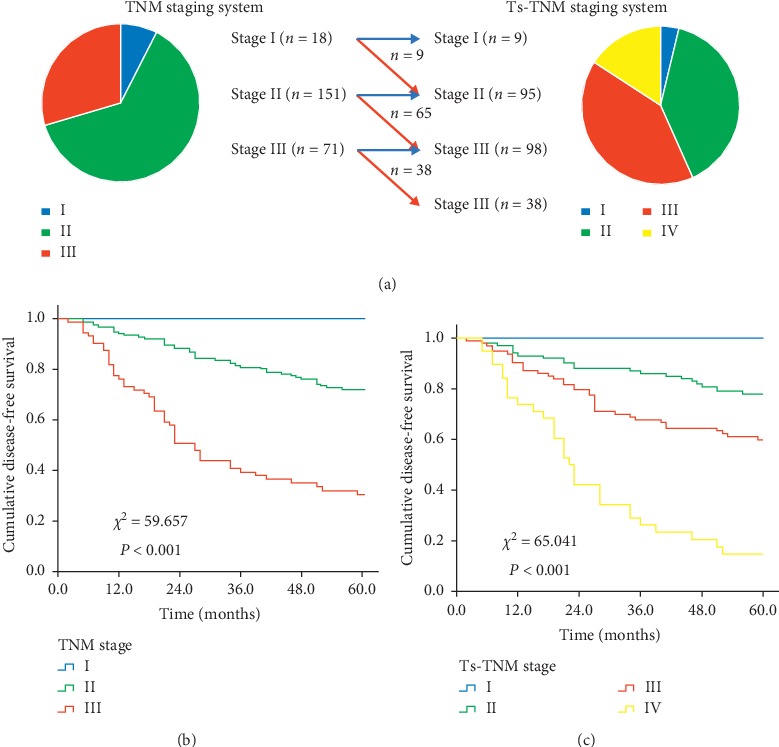
Patient distribution and prognostic analysis of the TNM and Ts-TNM staging system. Patients of low TSR (Ts1) in the TNM staging system were assigned to the next higher stage in the Ts-TNM staging system (red arrow), and patients of high TSR (Ts0) in the TNM staging system remained at the same stage in the Ts-TNM staging system (blue arrow) (Table 3). (a) Both TNM and Ts-TNM staging system can well distinguish BC patients into subgroups with different prognosis (b and c). TNM = tumor node metastasis; Ts-TNM = tumor-stroma tumor node metastasis; T = tumor; N = node.